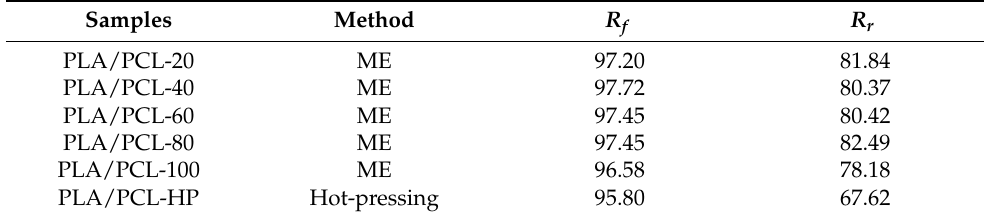
Figure 6. Shape memory cycle curves of ( a ) PLA/PCL-20, ( b ) PLA/PCL-40, ( c ) PLA/PCL-60, ( d ) PLA/PCL80, ( e ) PLA/PCL-100, ( f ) PLA/PCL-HP samples. Table 4. R f and R r of ME printed and hot-pressed PLA/PCL Samples